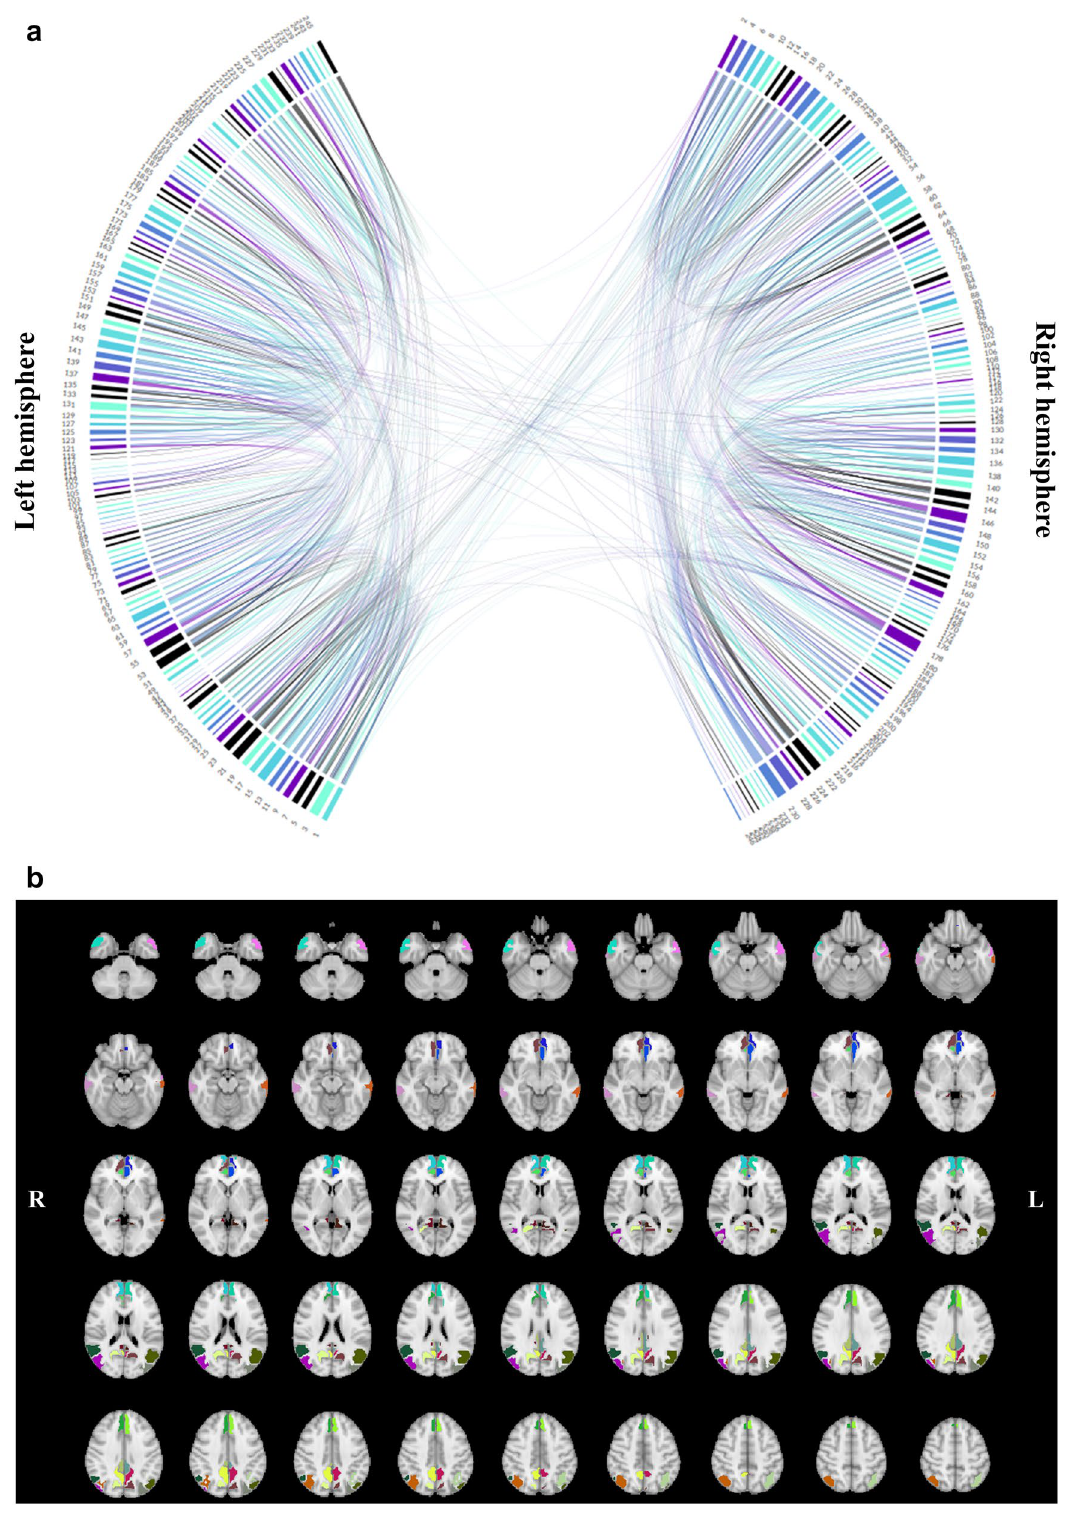
Figure 2. Regions of interest included in whole-brain and Default-Mode Network analyses. Investigated regions of interest (ROIs) were generated from Brainnetome Atlas parcellation, a list of brain regions can be found in Supplement 3 and on the Brainnetome homepage (https:// atlas. brain netome. org/ downl oad. html). ( a ) Of these 246 brain regions of the Brainnetome Atlas, only those ROIs that were interconnected by at least one streamline in all subjects of the control group were included in whole-brain analyses. Even numbers refer to right-hemispheric ROIs, whereas uneven numbers represent left-hemispheric ROIs. ( b ) For the analyses of the Default-Mode Network (DMN), atlas structures comprising hub regions such as the anterior cingulate cortex, posterior cingulate cortex, medial temporal gyrus and inferior parietal lobule were